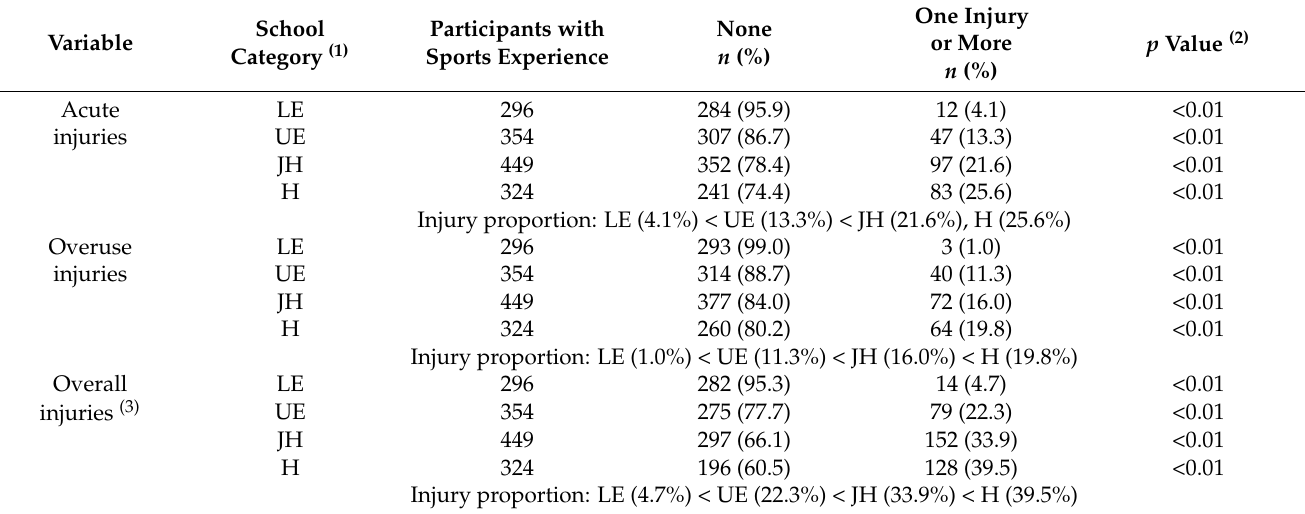
Table 2. The number of sports-related injuries in the study participants ( n = 484).